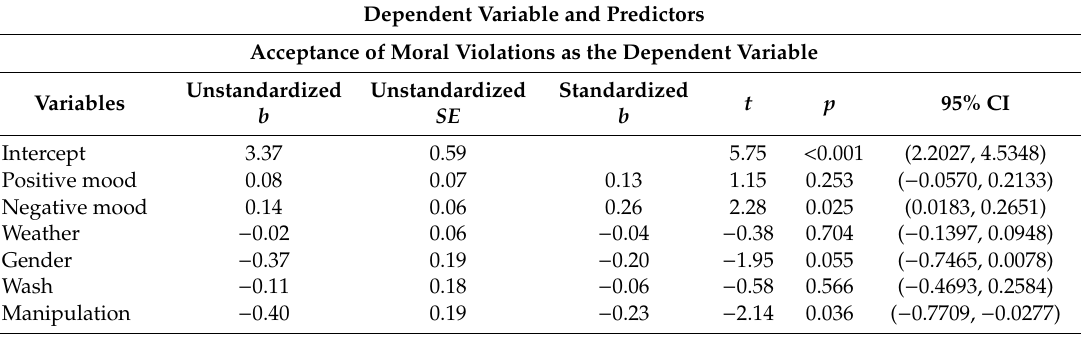
Table 4. The full regression results of Study